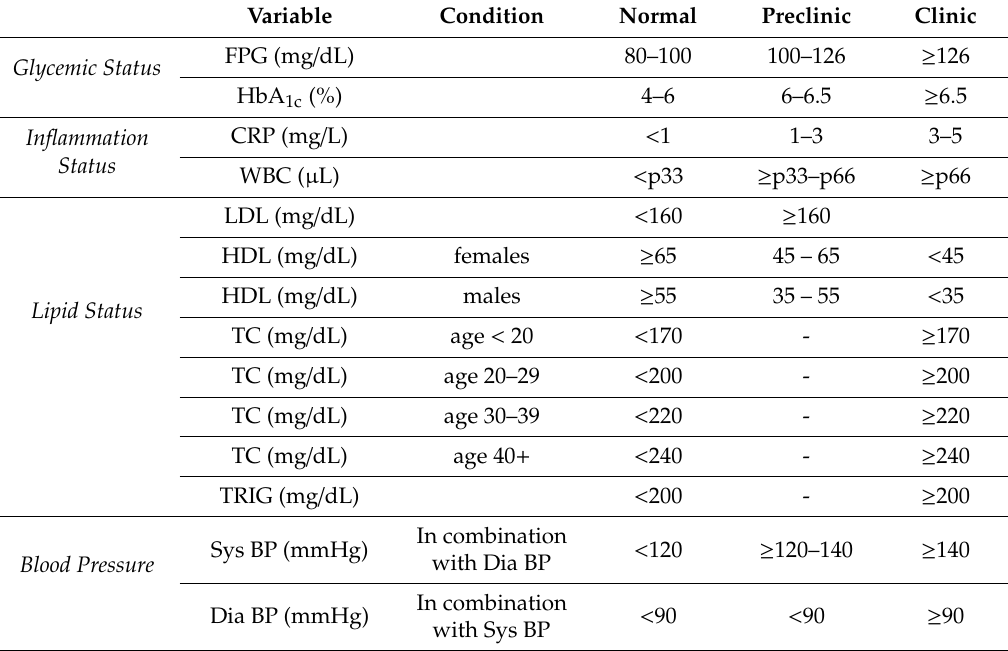
Table 1. Classification of biomarkers into (clinical)